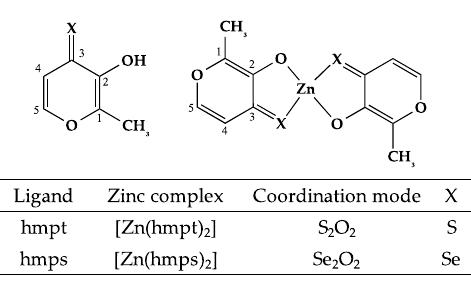
Figure 1. Chemical structures of organo-sulfur (S) and -selenium (Se) zinc (Zn) complexes.